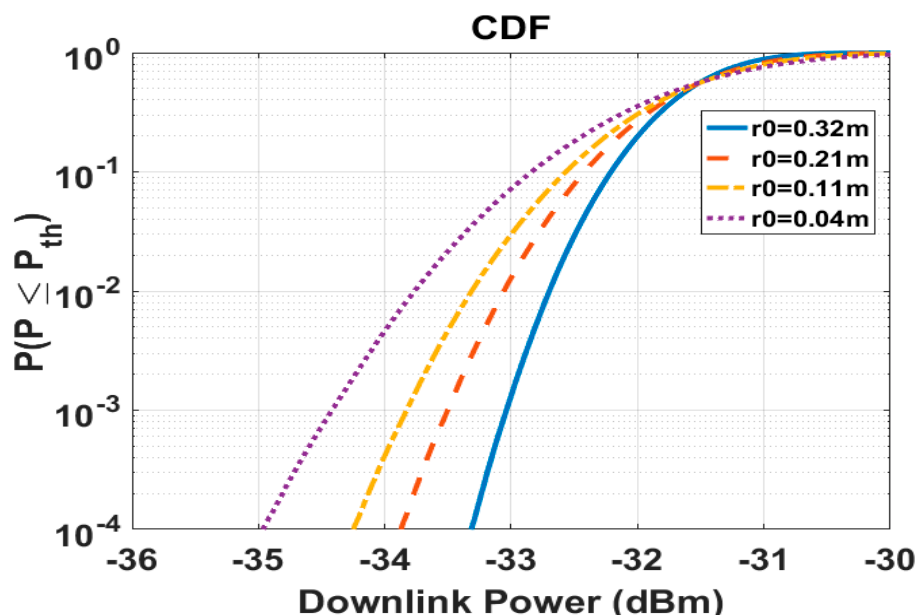
Figure 10. Downlink received power for various weather conditions.